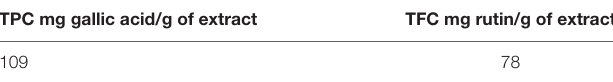
TABLE 1B | TPC and total flavonoid content of methanolic extract of O. limbata.